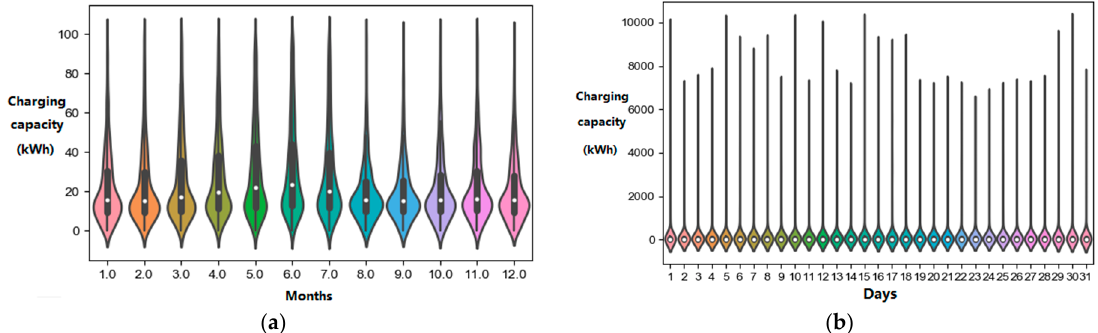
Figure 4. Violin chart of charging data distribution by month/day: ( a ) distribution by months; and ( b ) distribution by days.